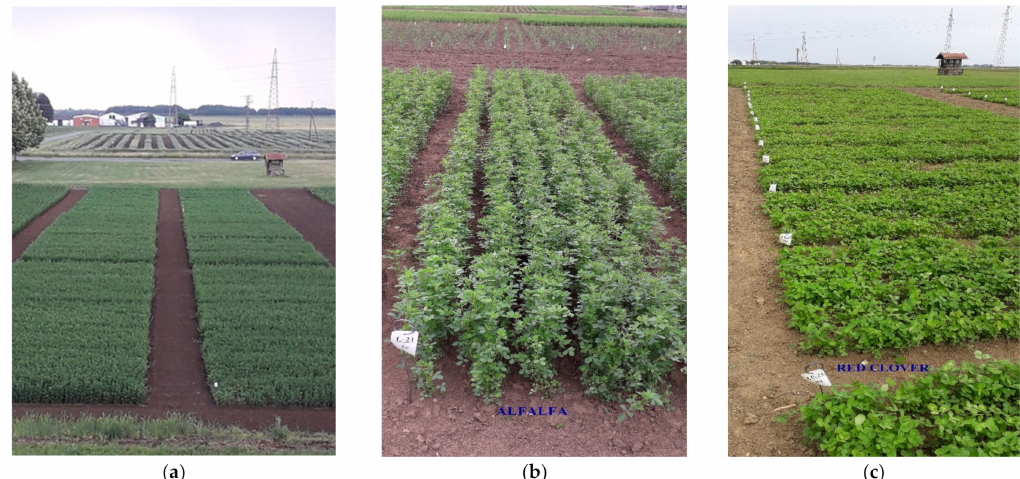
Figure 1. ( a ) Experimental site at the Agricultural Institute Osijek, Croatia; ( b ) Alfalfa field trial; ( c ) Red clover field trial.